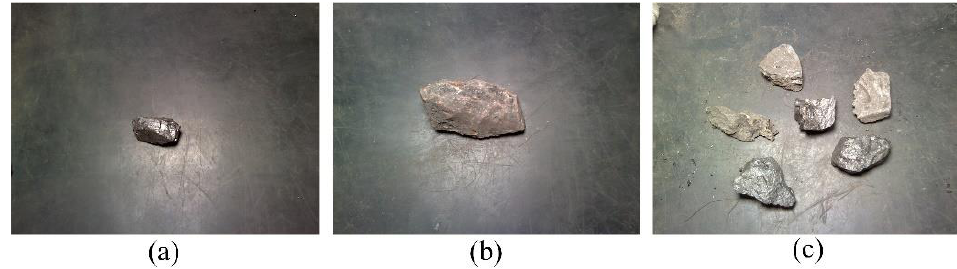
Figure 1. Sample pictures of coal and gangue ( a ) Coal, ( b ) Gangue ( c ) Coal mixed with gangue. LabelImg software manually annotated all images based on the collected dataset. The annotated text files containing category and coordinate information were generated. The annotated dataset is divided into training and validation sets in a ratio of 4:1 while ensuring no duplicate information between each group. The collection information of coal and gangue is shown in Table 1. Table 1. Coal and gangue data set information.